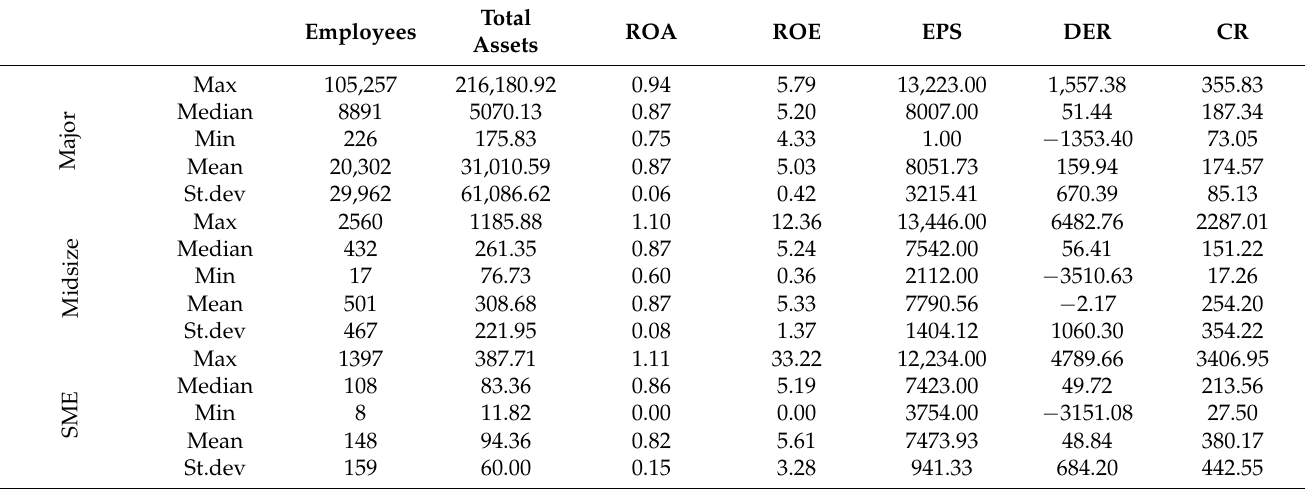
Table 2. Descriptive statistics: ICT manufacturing